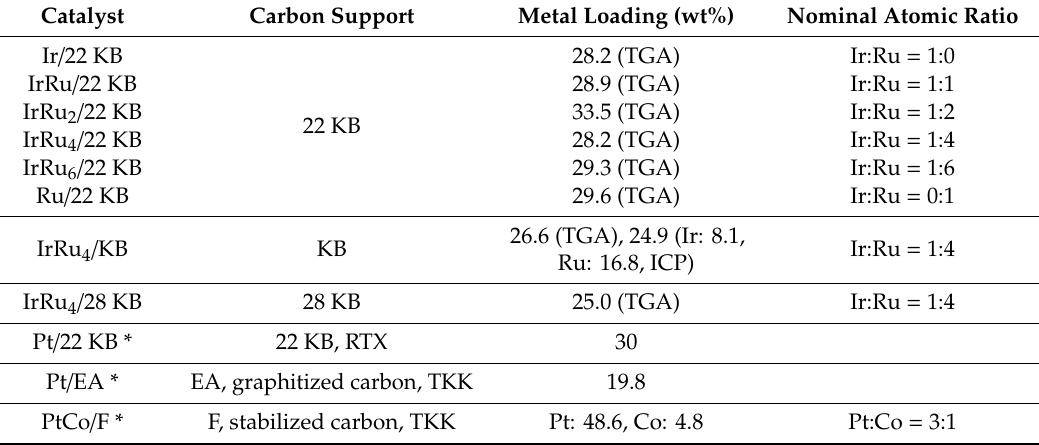
Table 1. Notation and brief specification of catalysts used in this study. Nonplatinum catalysts were synthesized and Pt-based catalysts * were purchased from commercial